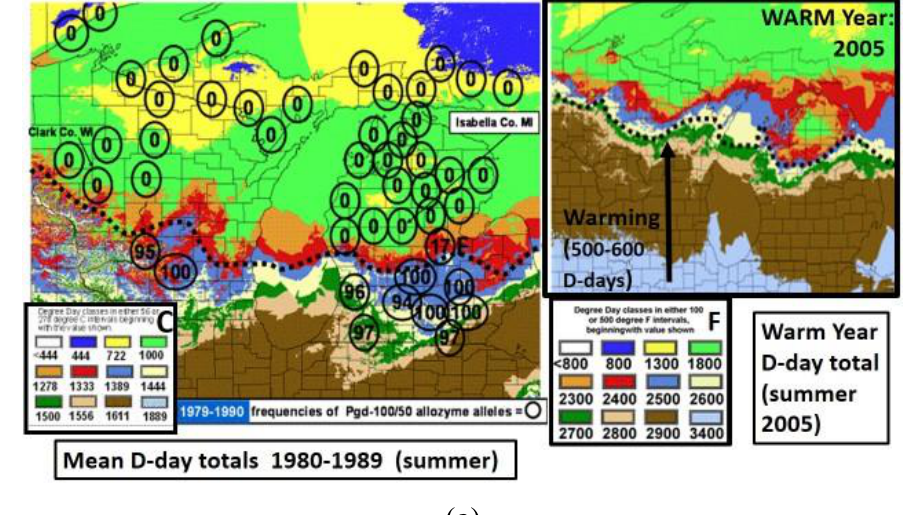
Figure 16. ( a ) Species diagnostic Z-linked frequencies of allozyme alleles (Pgd-100, or 50) in Michigan Papilio populations before 1991, shown with the 10-year average thermal landscape in degree-days (°F). A warmer year is shown in the upper right. During this period, the Z-linked Ldh allozyme frequencies were similar to the Pgd allozymes shown here [332,365]; ( b ) Species diagnostic Z-linked frequencies of allozyme alleles (Pgd-100, or 50) in Michigan Papilio populations post-1991, shown with the 10-year average thermal landscape in degree-days (°F). A warmer year is shown in the upper right. (cid:36)(cid:79)(cid:86)(cid:82)(cid:3) (cid:86)(cid:75)(cid:82)(cid:90)(cid:81)(cid:3) (cid:73)(cid:82)(cid:85)(cid:3) (cid:70)(cid:82)(cid:80)(cid:83)(cid:68)(cid:85)(cid:76)(cid:86)(cid:82)(cid:81)(cid:3) (cid:68)(cid:85)(cid:72)(cid:3) (cid:87)(cid:75)(cid:72)(cid:3) (cid:73)(cid:85)(cid:72)(cid:84)(cid:88)(cid:72)(cid:81)(cid:70)(cid:76)(cid:72)(cid:86)(cid:3) (cid:82)(cid:73)(cid:3) (cid:87)(cid:75)(cid:72)(cid:3) (cid:68)(cid:88)(cid:87)(cid:82)(cid:86)(cid:82)(cid:80)(cid:68)(cid:79)(cid:3) (cid:179)(cid:74)(cid:79)(cid:68)(cid:88)(cid:70)(cid:88)(cid:86) -like allozyme alleles of HK-100 (hexokinase), which were also at zero frequency north of the historical hybrid zone (dotted line) before 1991 (also see [332]). During the years after 1991,